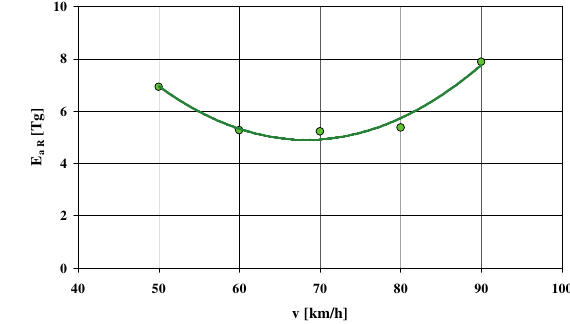
Fig. 16. Dependence of the national annual emission of particulate matter from the exhaust system of passenger car engines upon the average velocity, under model conditions of urban traffic